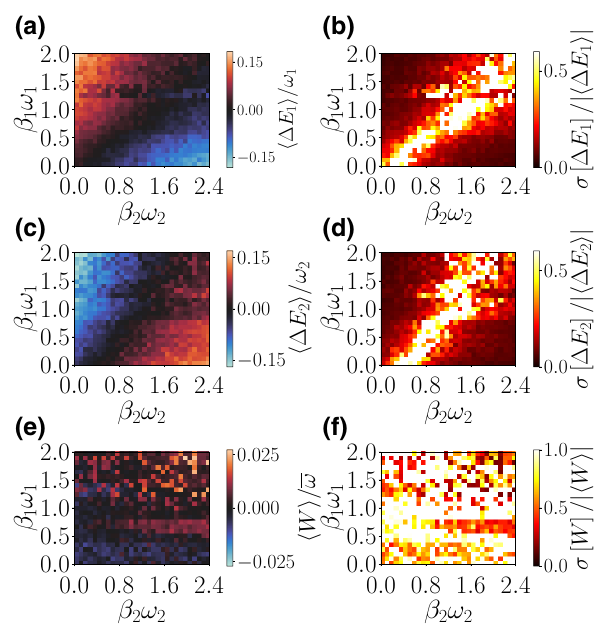
FIG. 14. (a),(c),(e) Measured rescaled energy exchanges (cid:2) /ω (cid:5) (cid:10) E (cid:2) /ω (cid:5) W (cid:2) /ω , for the QMC engine design in (cid:5) (cid:10) E 1 1 , 2 2 , Fig. 12 as a function of nominal inverse rescaled temperatures ω β ω β 1 1 , 2 2 . (b),(d),(f) Their relative experimental